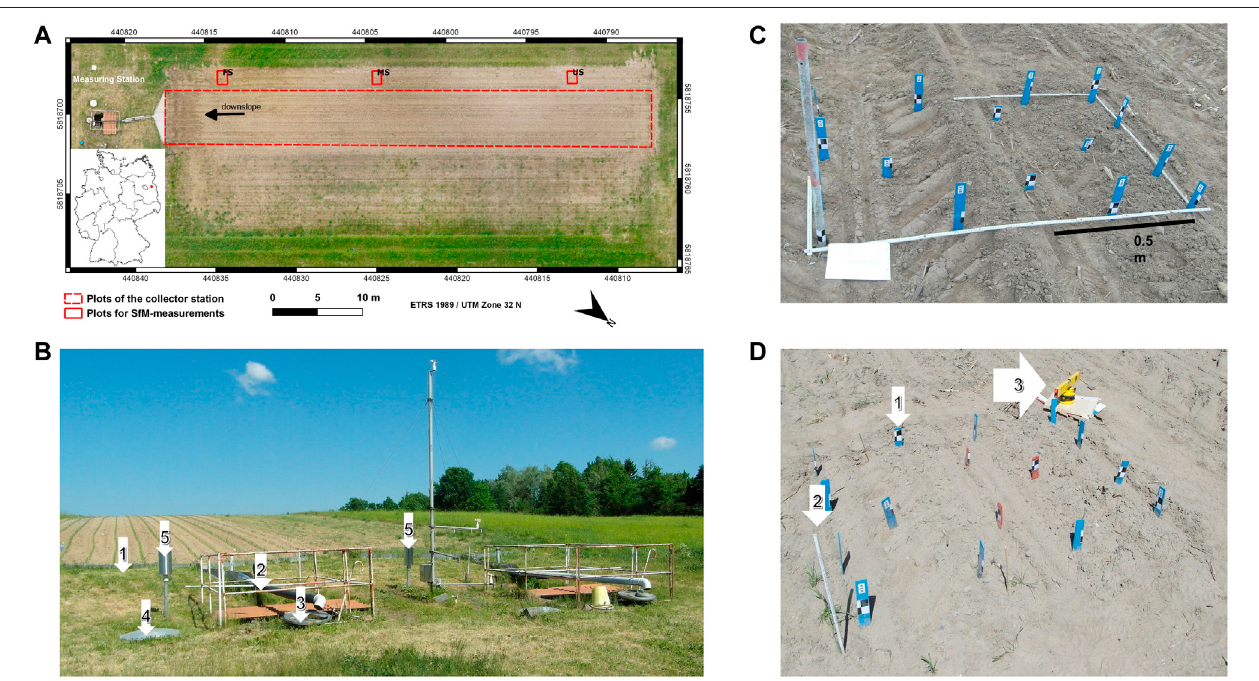
FIGURE 1 | (A) Location of the erosion measurement hillsite in Germany (bottom left inlet) and photo image of the hillslope with the collector stations and SfM- plots at the three slope positions: FS (footslope), MS (middle slope), and US (upper slope); (B) Set-up of the erosion measurement station: 1) V-shaped sediment collector, 2) Venturi channel system, 3) sample splitting device, 4) tank, and 5) rain gauge; (C) Experimental set-up for the assessment of soil erosion with SfM at the footslope (FS); (D) Referencing of the GCPs 1) with folding rule 2), and laser level